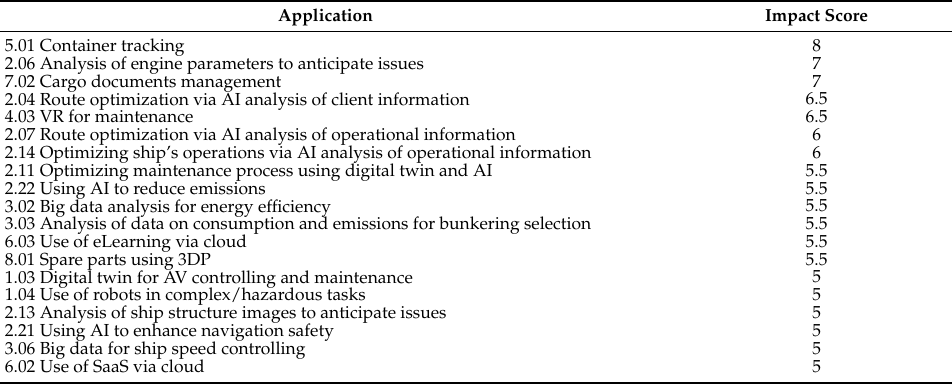
Table 4. List of applications with higher consolidated impact score.